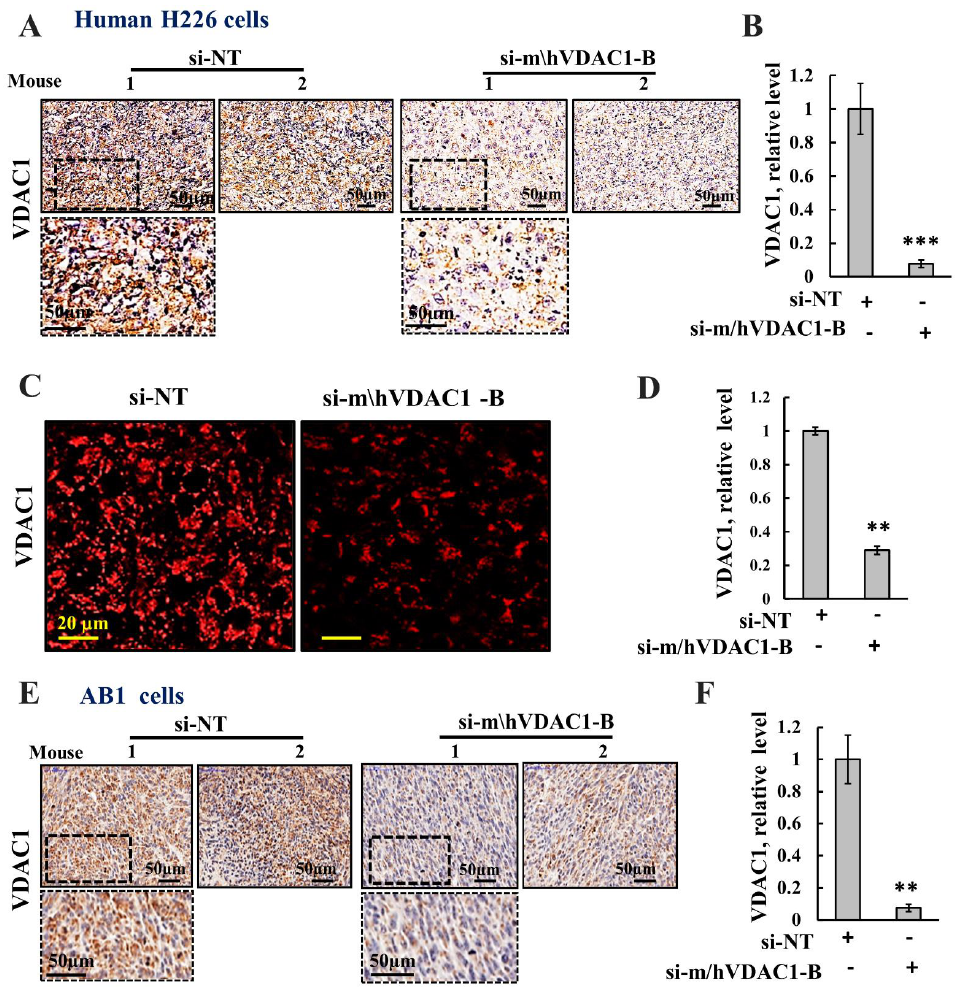
Figure 4. si-m/hVDAC1-B downregulates VDAC1 expression. ( A – D ) Representative VDAC1 IHC ( A , B ) and IF ( C , D ) stained sections from si-m/hVDAC1-B-treated or si-NT-treated H226-derived tumors and their quantification ( B , D ). ( E , F ) AB1 cell-derived tumors IHC stained for VDAC1 ( E ) and their quantification ( F ). Results are presented as means ± SEM, ** p ≤ 0.01; *** p ≤ 0.001. Next, we assessed the expression levels of several metabolism-related enzymes in tumor sections from H226 cell-derived tumor that were treated with si-NT or sim/hVDAC1-B and were IHC stained using specific antibodies for glycolytic enzymes, hexokinase 1 (HK-I), lactate dehydrogenase (LDH), the TCA cycle enzyme, citrate syn- thase (CS), and ATP synthesizing enzyme subunit 5A (Figure 5A,B). In addition, sections were IF stained for the glucose transporter (Glut-1) (Figure 5C,D). The levels of these pro- teins were highly reduced in the si-m/hVDAC1-B-treated tumors, relative to their levels in si-NT-treated tumors.